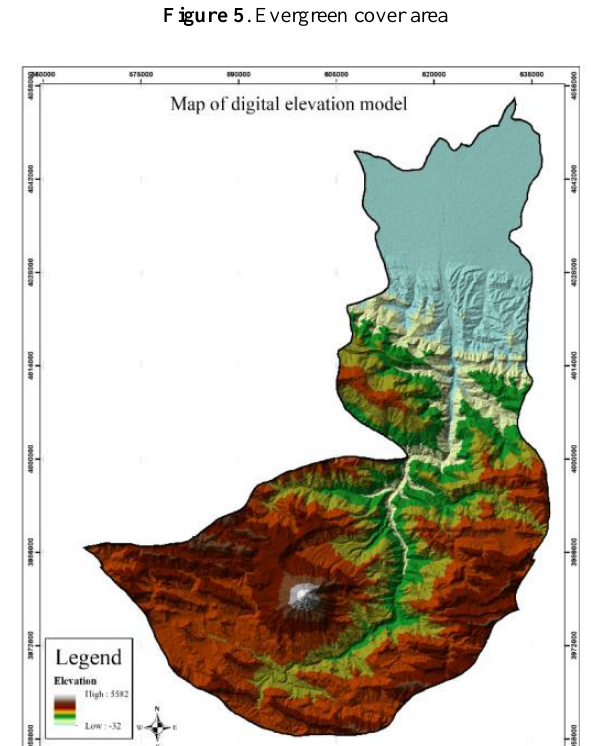
Figure 7 . Rice paddy